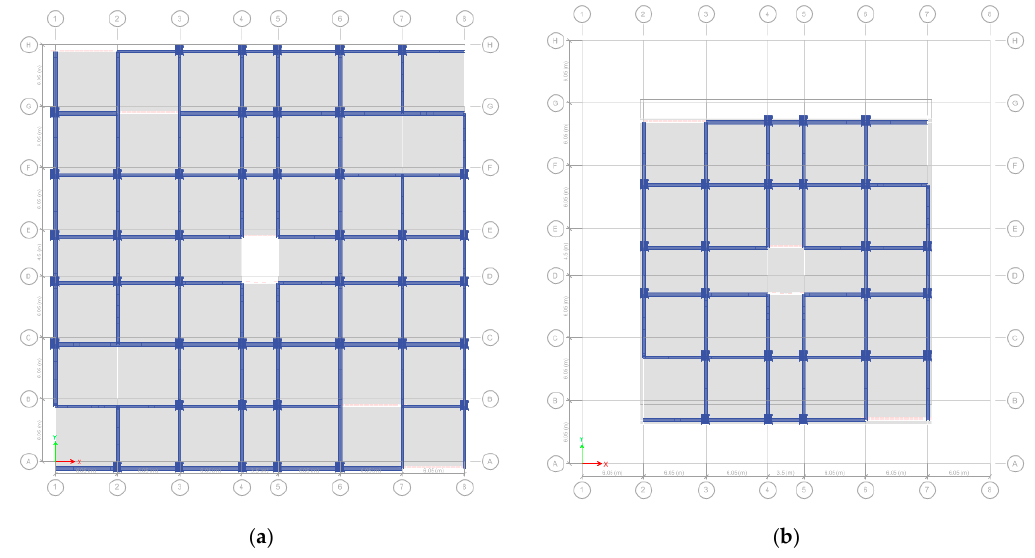
Figure 18. The 2nd mode shape for T 2 = 0.512 s: ( a ) plane view of the 1st floor, and ( b ) plane view of the 10th floor.